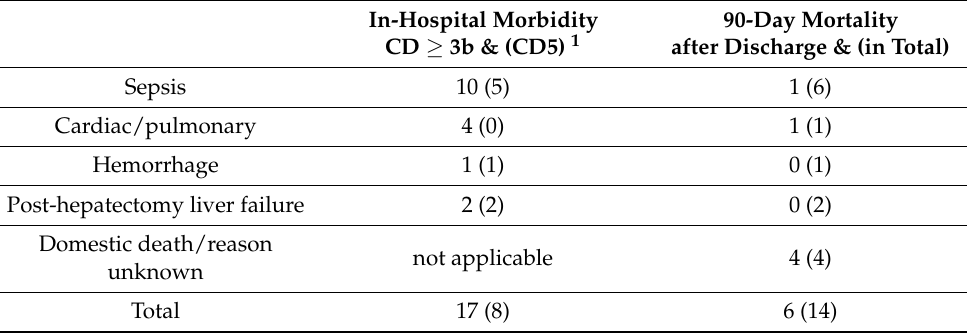
Table 2. Major morbidity and 90-day mortality.